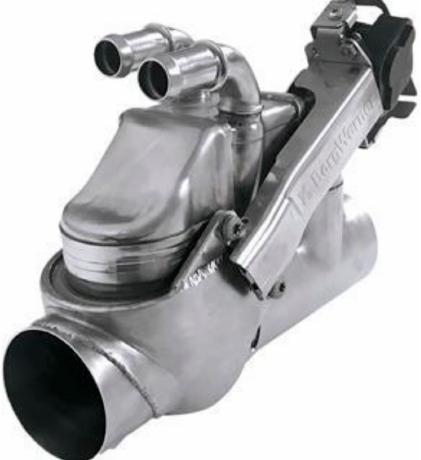
Figure 4. Exhaust Waste Heat Recovery (EWHR) Unit.